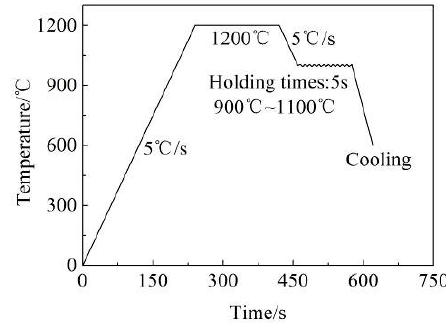
Figure 2. Technological process.